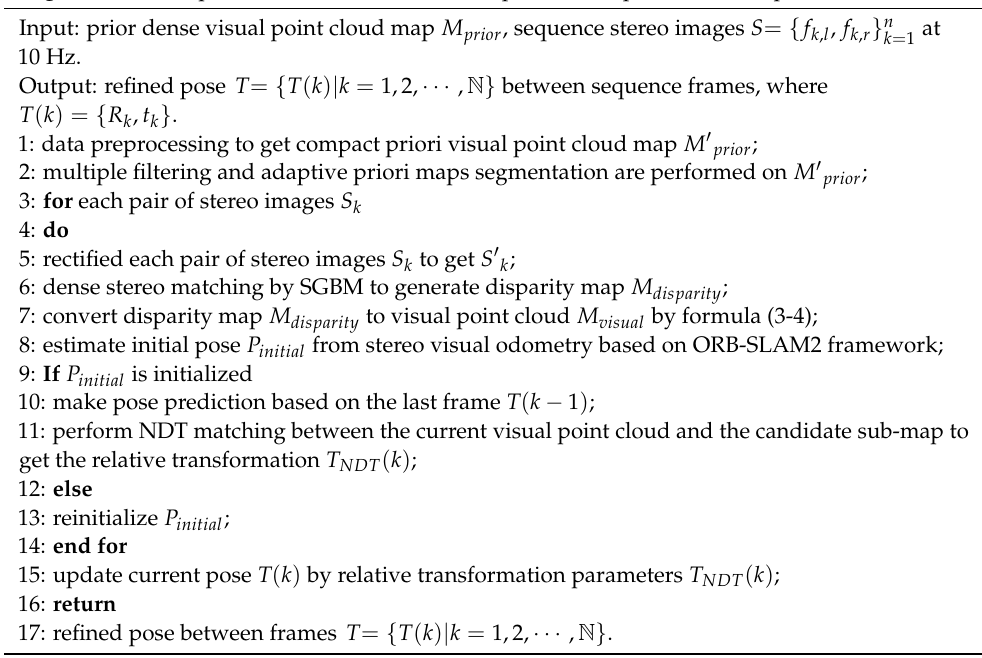
Algorithm 1. The procedure of localization with prior visual point cloud map